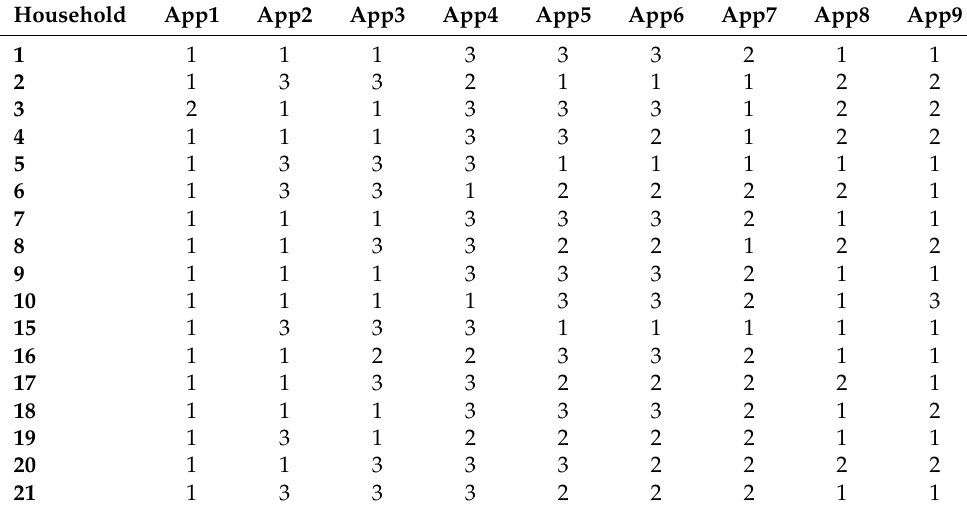
Table 5. The allocated priorities to each appliance in each